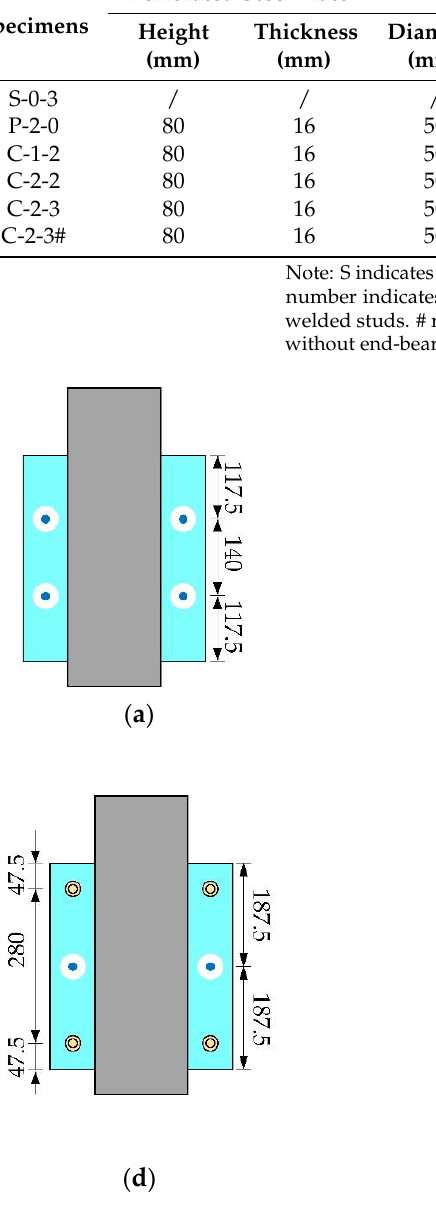
Figure 2. Details of specimen: ( a ) S-0-3; ( b ) P-2-0; ( c ) C-1-2; ( d ) C-2-2; ( e ) C-2-3; ( f ) C-2-3# (unit: mm).